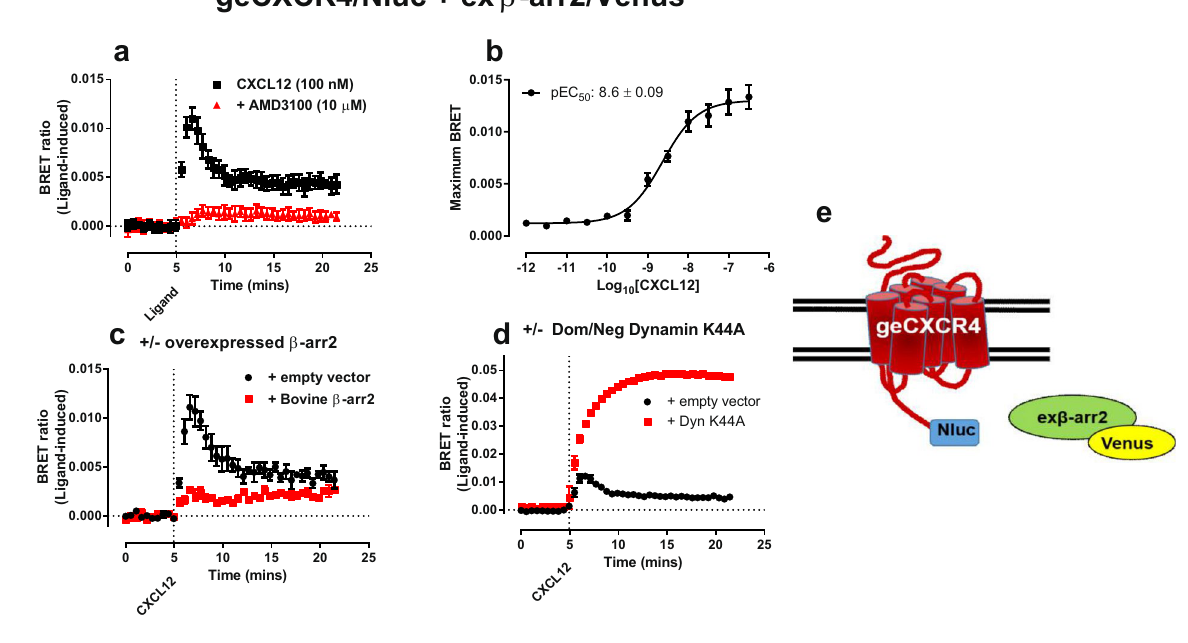
Figure 1. Monitoring β -arrestin2 recruitment to genome-edited CXCR4/Nluc using BRET. HEK293FT cells expressing genome-edited CXCR4 fused to Nluc (geCXCR4/Nluc) transiently transfected with cDNA coding for β -arrestin2/Venus (ex β -arr2/Venus) were used to ( a ) determine ligand-dependent CXCL12 (100 nM) recruitment of β -arrestin2 to CXCR4 in the absence or presence of the CXCR4 antagonist AMD3100 (10 µ M). ( b ) Application of CXCL12 (1 pM–300 nM) resulted in a concentration-dependent recruitment of ex β -arr2/ Venus to geCXCR4/Nluc. Modulation of CXCL12 (30 nM) mediated ex β -arr2/Venus recruitment to geCXCR4/ Nluc by ( c ) additional co-expression of untagged bovine β -arr2 or ( d ) dominant-negative dynamin K44A. ( e ) Schematic representation of the BRET configuration. ‘BRET ratio (ligand-induced)’ was calculated as described in Methods . Points represent mean ± S.E.M. of three (c and d), four ( a ) or five ( b ) independent experiments. ( b ) Concentration-response curve fit was by non-linear regression and was used to calculate pEC 50 , with points representing maximum response observed in a kinetic